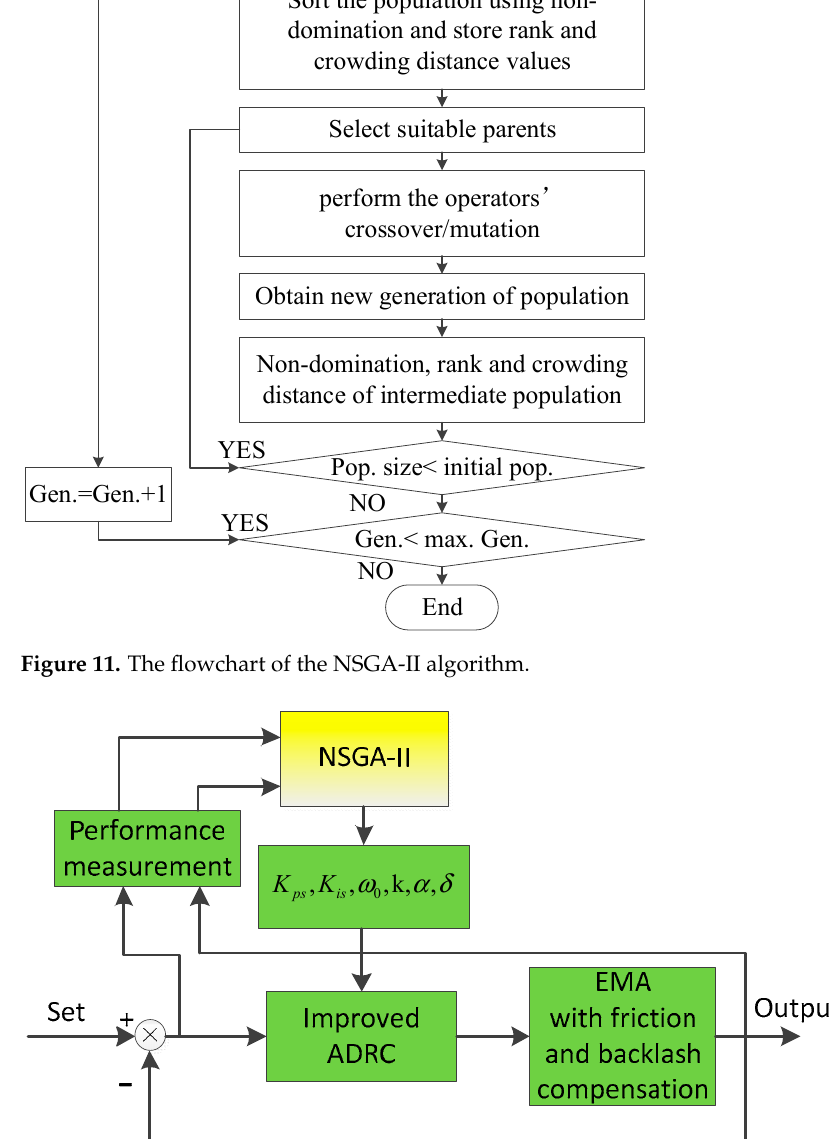
Figure 12. The optimization procedure of tuning improved ADRC parameters.